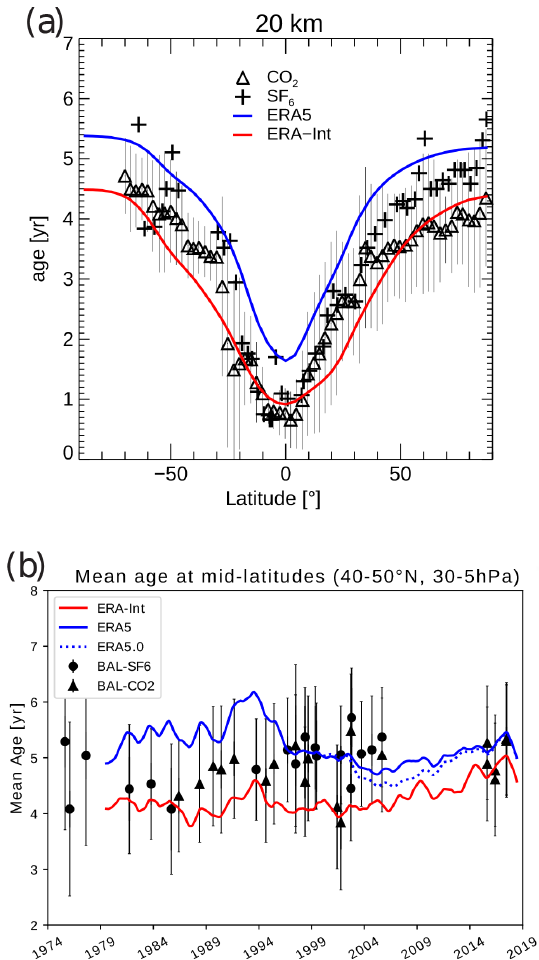
Figure 10. (a) Mean age of air at 20km at different latitudes from in situ observations (black symbols, from Waugh, 2009), from ERA5 (blue) and ERA-Interim (red) driven CLaMS simulations. (b) Mean age time series in the NH middle latitudes (40–50 ◦ N and 30–5hPa, approximately 600–1200K for reanalyses). Coloured lines show the mean age from reanalyses (smoothed with a 12-month running mean), and black symbols show the mean age from the balloon- borne observations of Engel et al. (2017), with error bars represent- ing the uncertainty of the